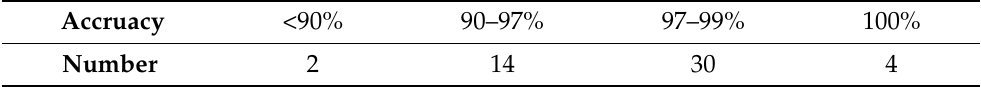
Table 6. The authentication performance of the model on these 50